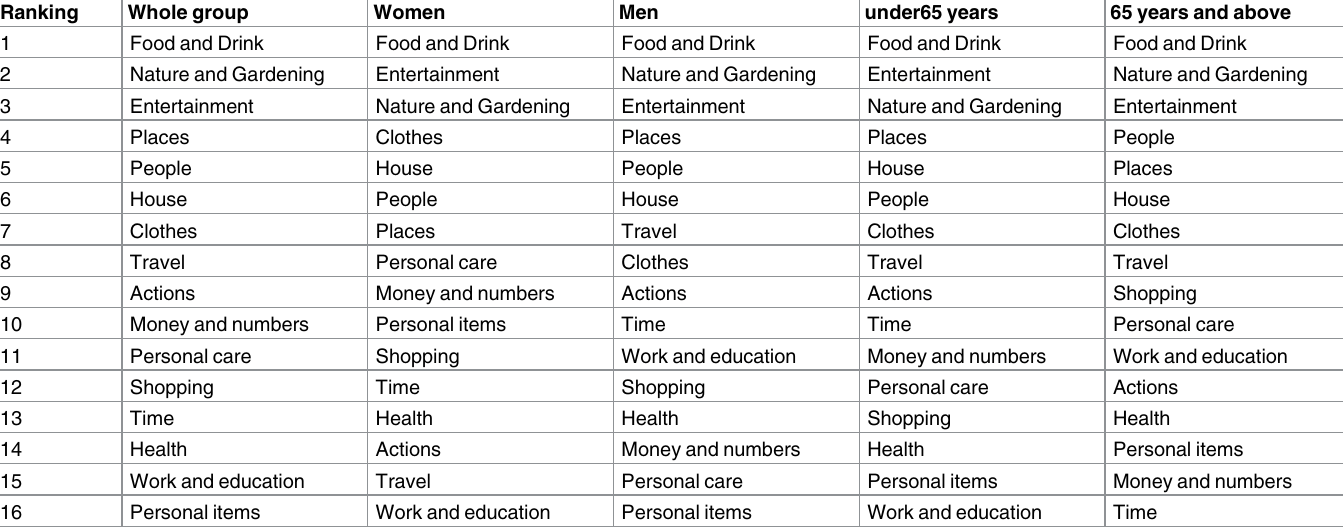
Table 5. Ranking of topics by